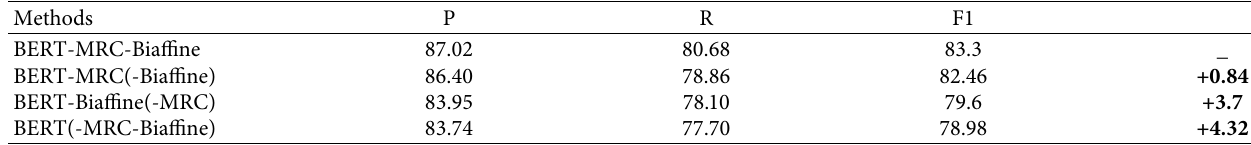
Table 7: The performance between full model and removed component models in TCM dataset.